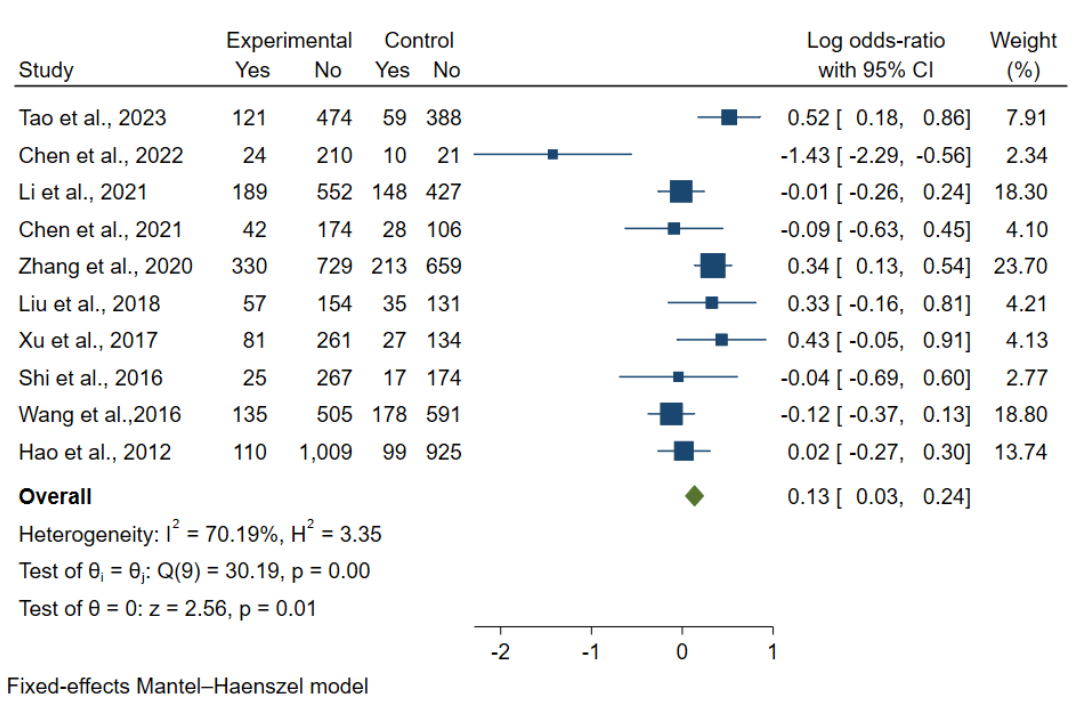
Fig. 3. The forest plot showed an odds ratio of metastatic lymph nodes harvested between the two groups. Unintentional parathyroid gland removal